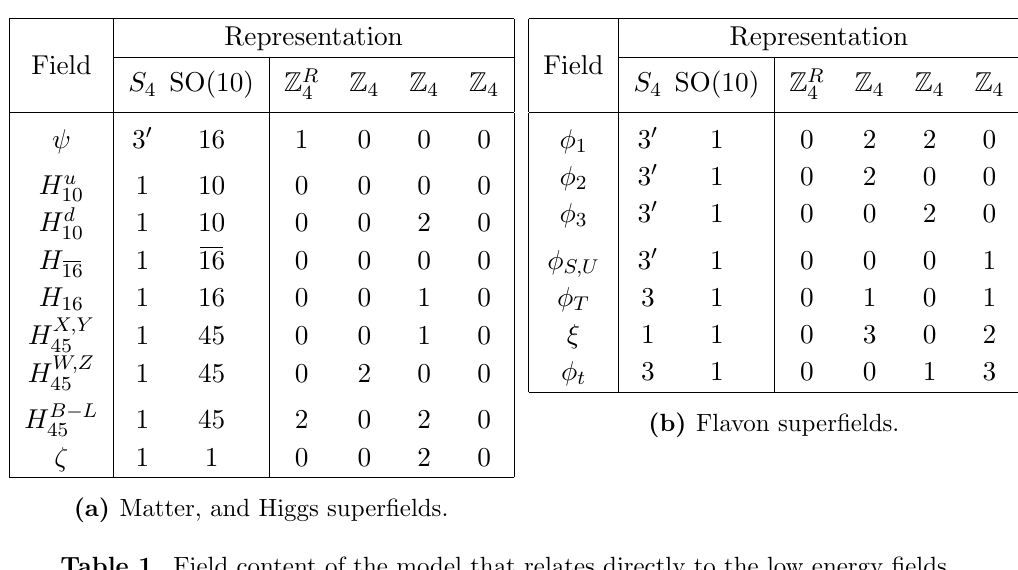
Table 1. Field content of the model that relates directly to the low energy